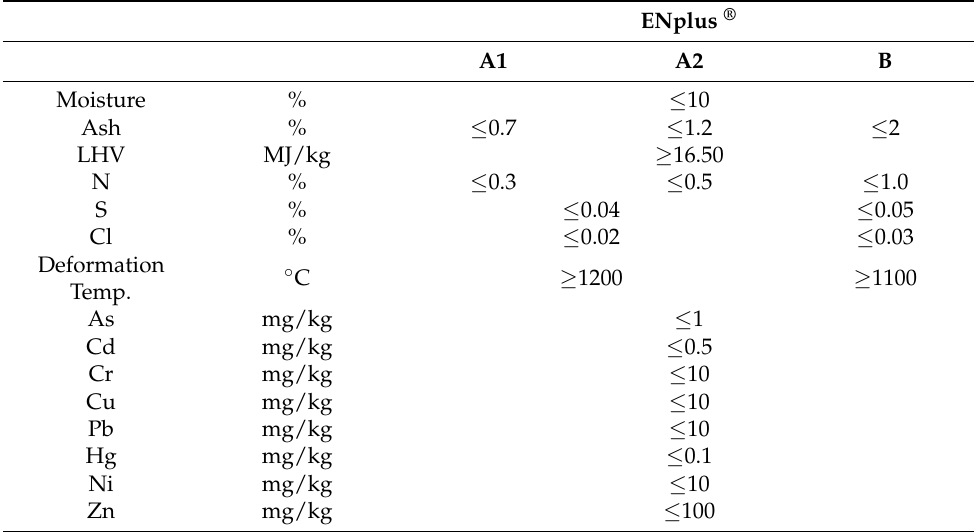
Table 1. Limit values for properties defined by the ENplus ® standard.